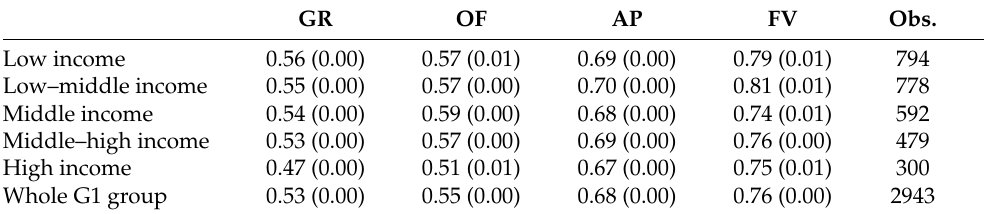
Table 4. Estimation results for income elasticity among the different subgroups of the G1 group. GR OF AP FV